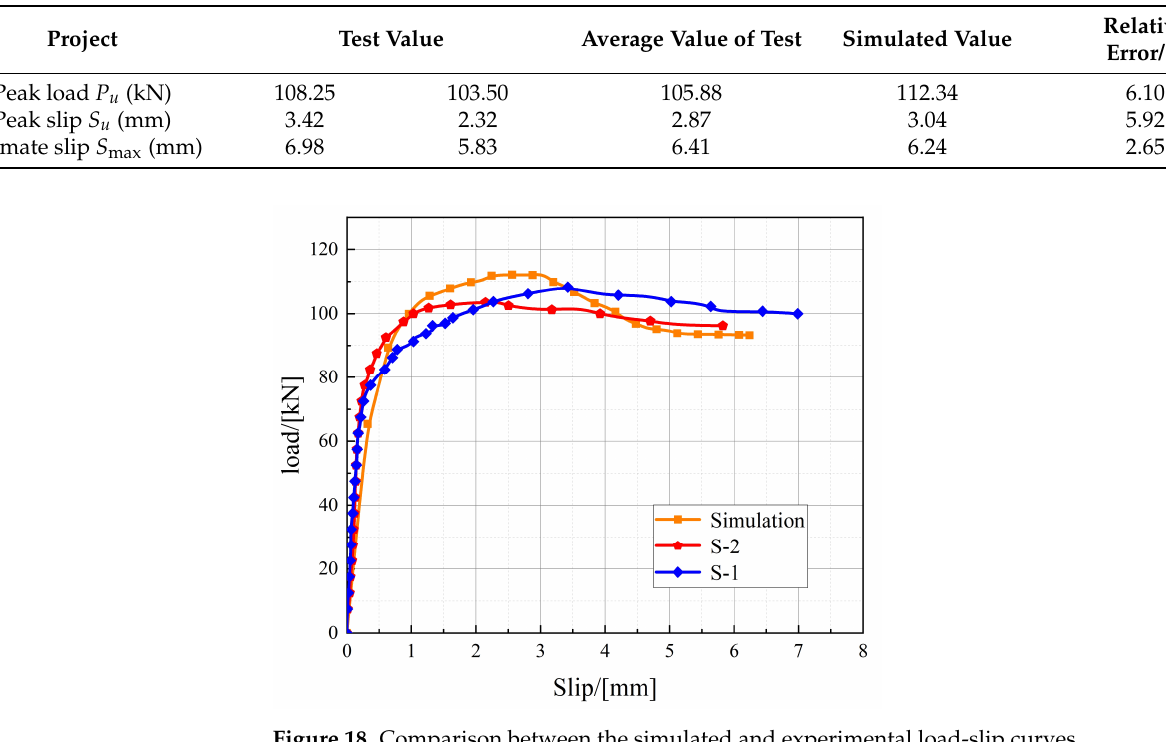
16 of 23 Figure 16. Stress cloud image of the specimen: ( a ) stud and welding ring; ( b ) concrete.